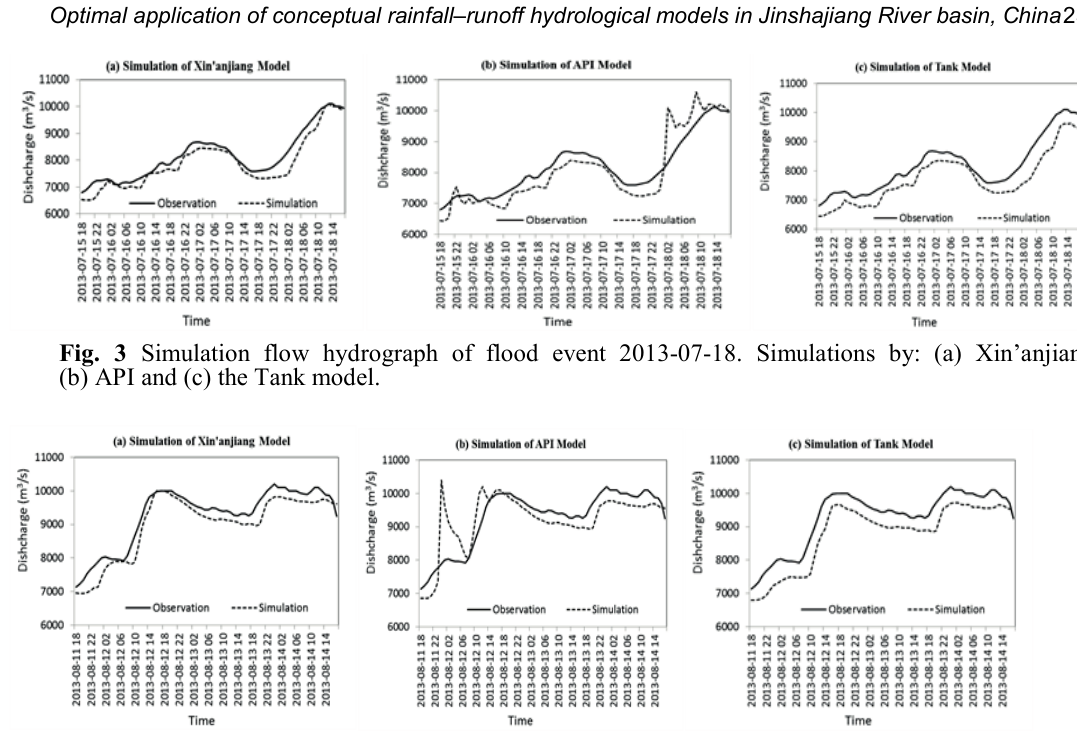
Fig. 4 Simulation flow hydrograph of flood event 2013-08-14. Simulations by: (a) Xin’anjiang, (b) simulation of API model (c) Simulation of Tank